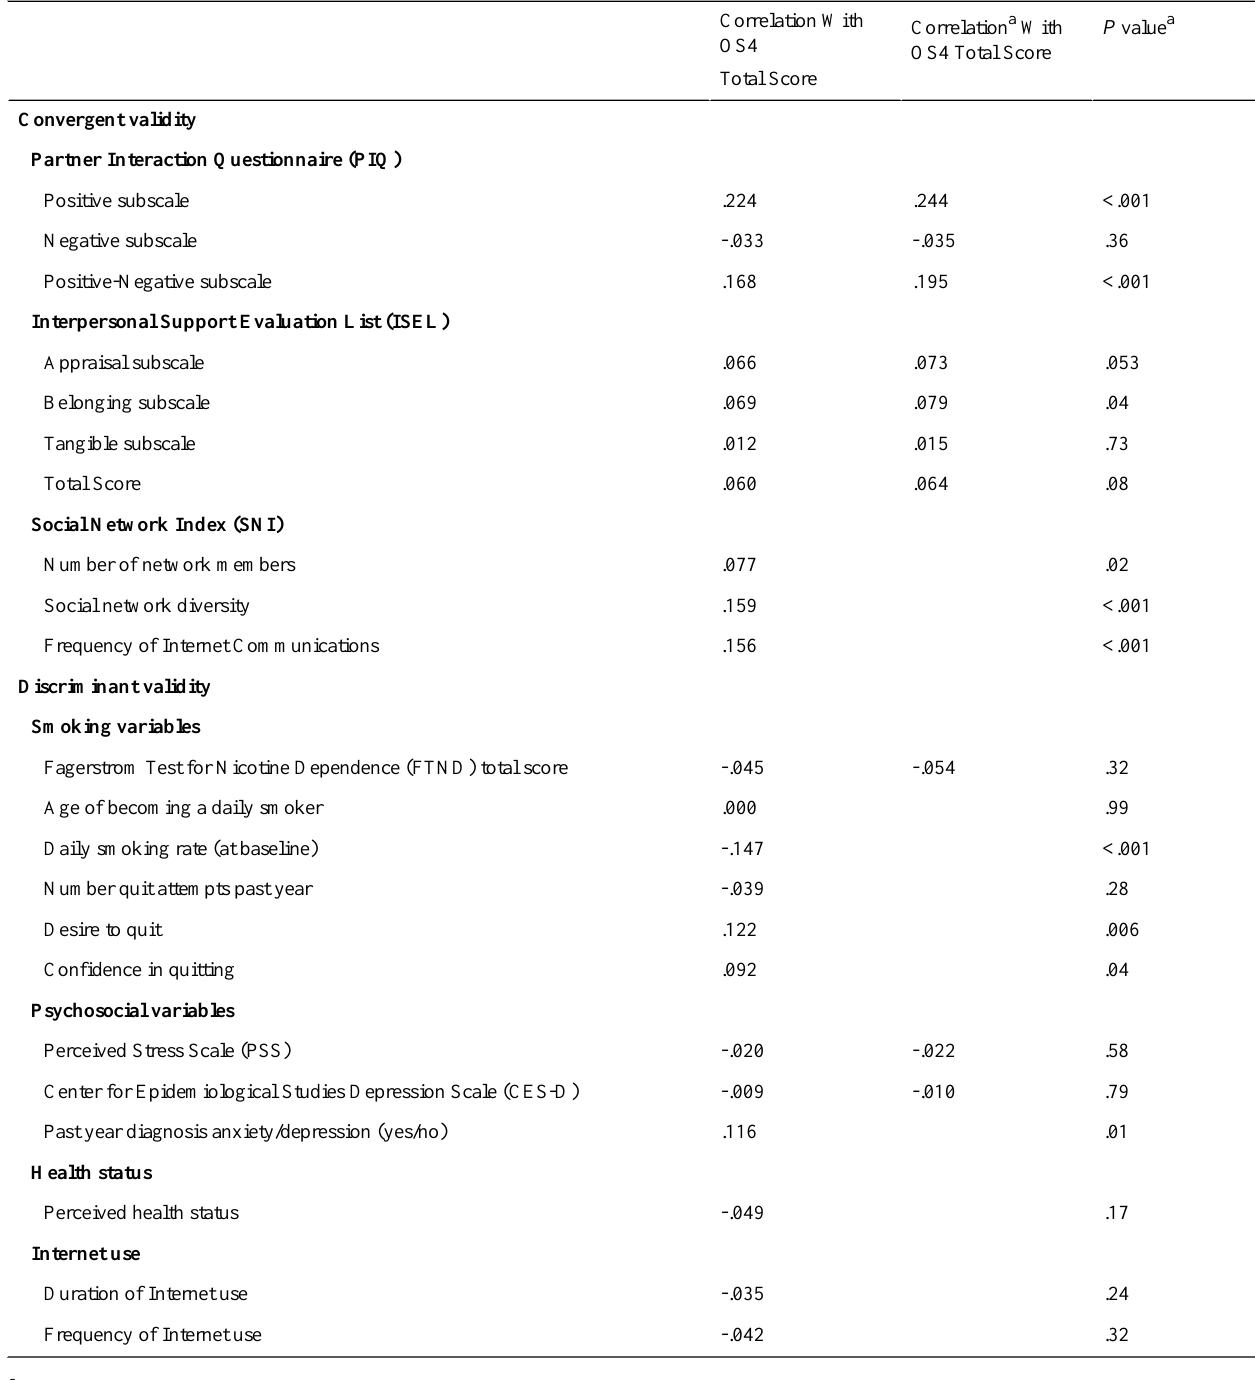
Table 2. Construct validity